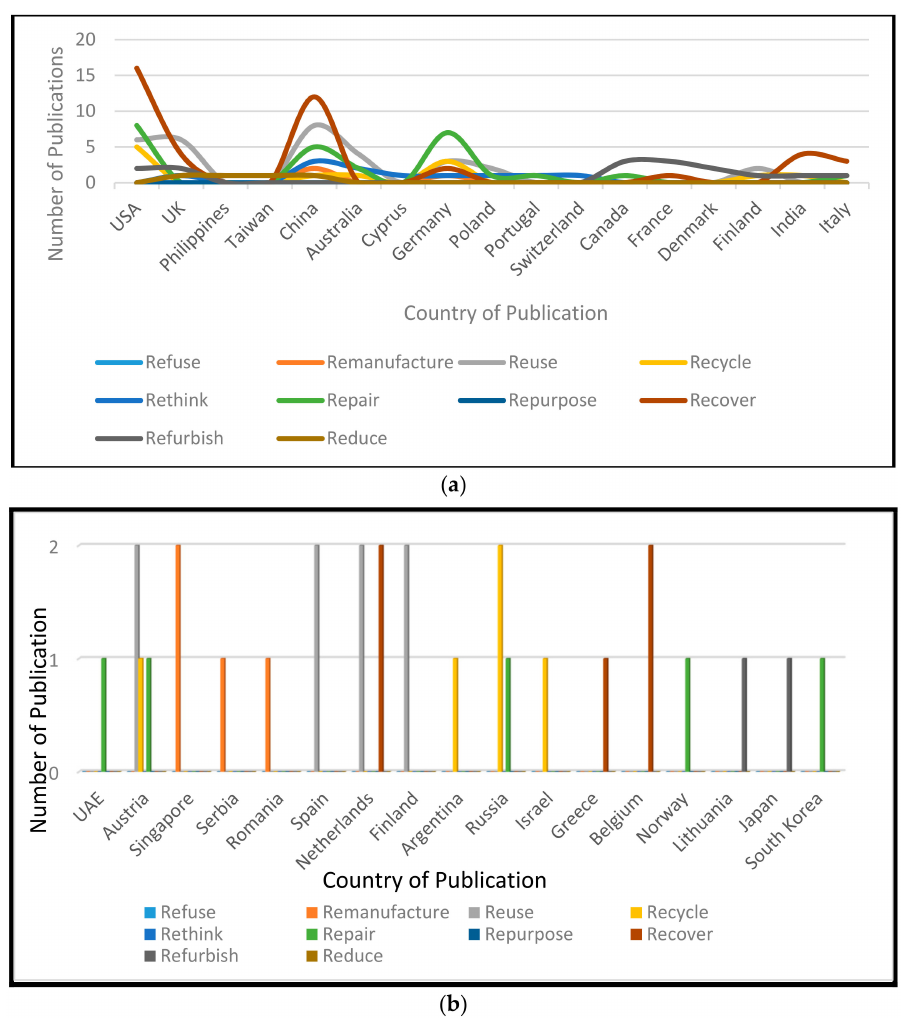
Figure 9. Papers distribution across countries of publication ( a ); Papers distribution across countries of publication ( b